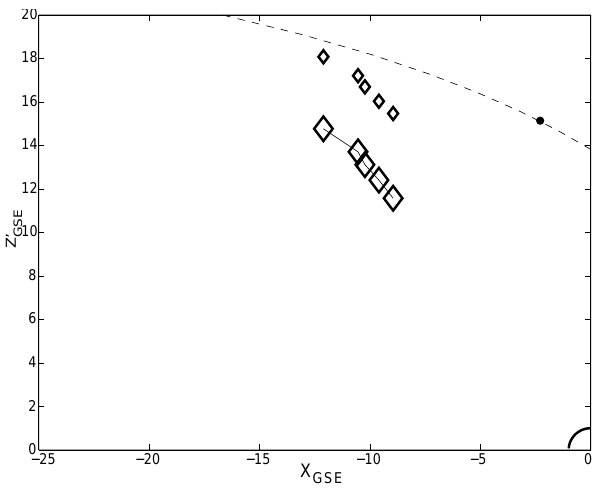
Fig. 10. The locations (the larger diamonds joined with the thin line) of the field lines conjugate with the poleward edge of auroras observed by ITACA at 14:46:20 UT (Fig. 5) in the plane defined by the Samba location and the X -axis of the GSE coordinate system. The dashed line shows the magnetopause location according to the model by Shue et al. (1997). The smaller diamonds show the max- + Z 2 ) 1 / 2 ) of the traced field imum radial extents (R = (Y 2 GSE GSE